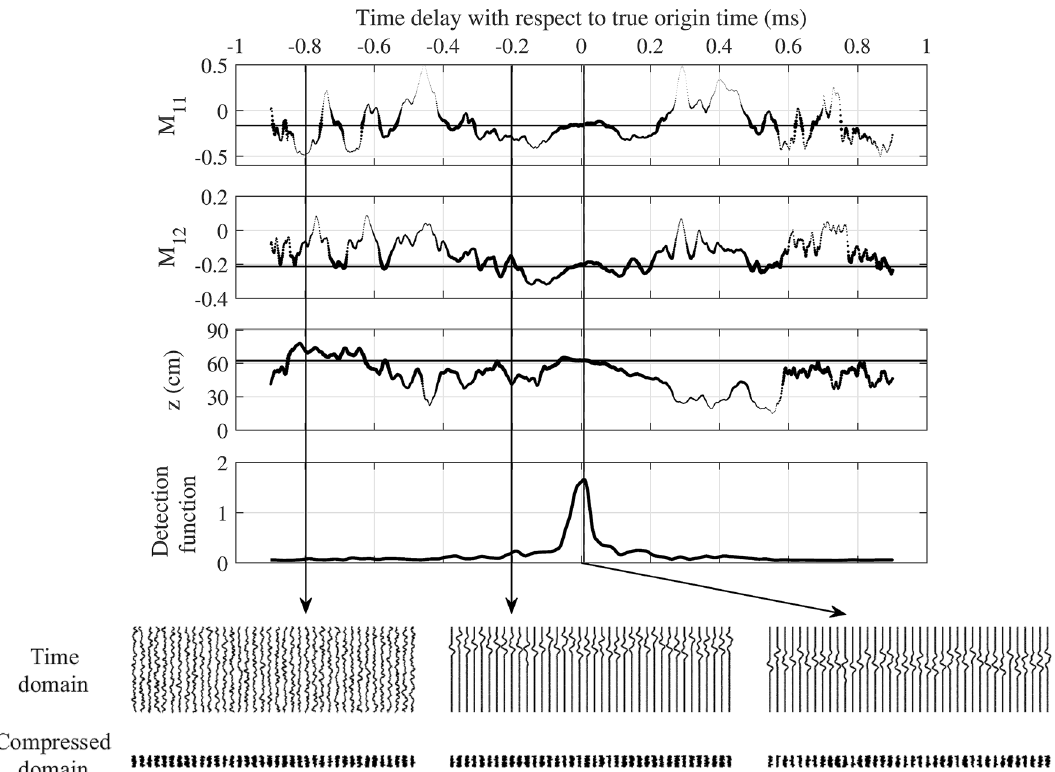
Figure 3. Detection function for deepCoSeL. Top three panels: examples of time series of deepCoSeL predictions (i.e., p k j ) in a continuous processing setting (dotted lines). The size of the dots are increased as the prediction approaches the correct value of the model parameter (horizontal solid lines). Fourth panel from top: detection function constructed with a combination of the nine times series of deepCoSeL predictions. Bottom panels: time domain seismograms (displayed for reference) and their corresponding compressed domain representations (input to DCNN) at three selected positions in time, including at the peak of the detection function. In this example N w = 30, N ov = 25 and N sm = 40 samples (see text for